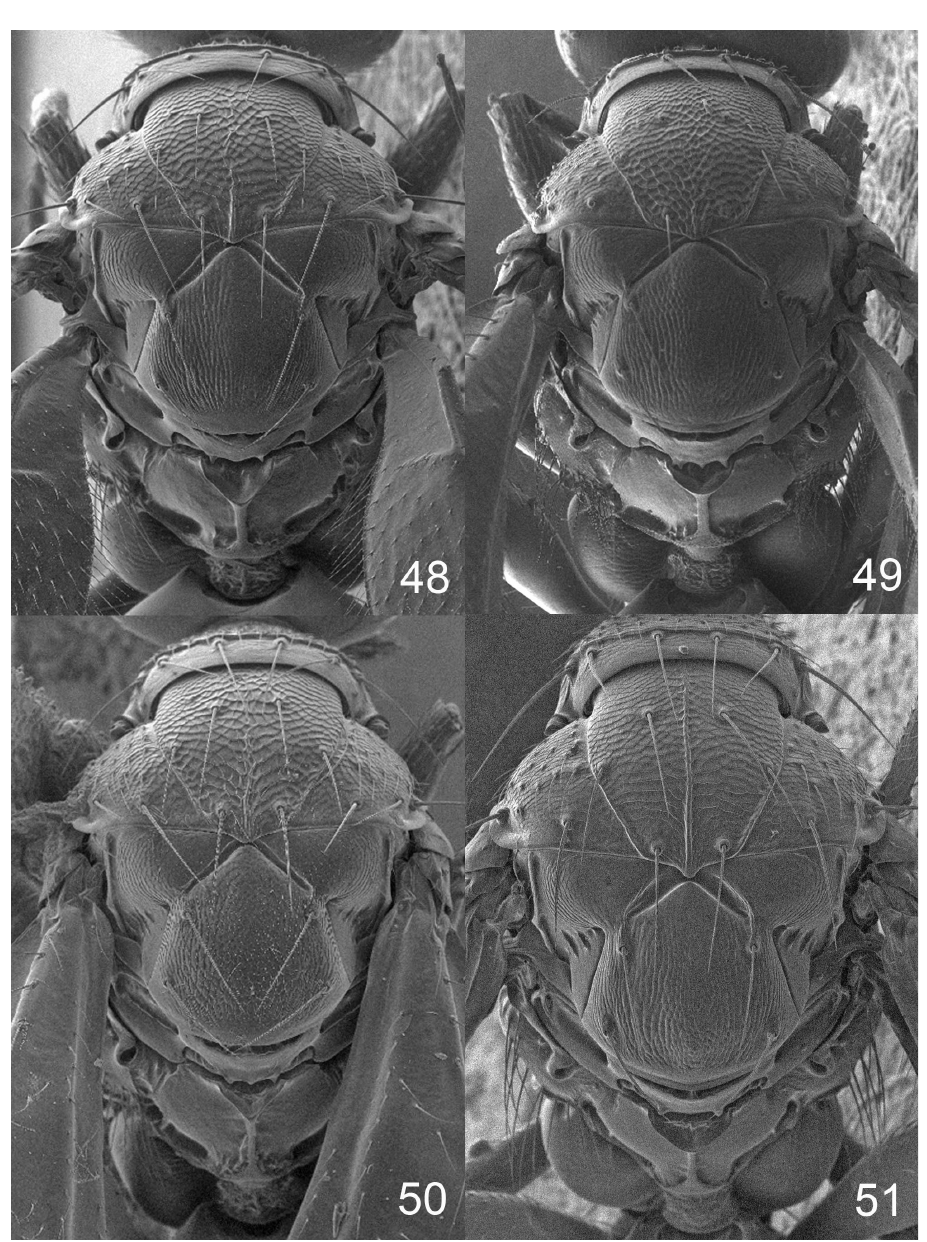
Figures 48–51. Euplectrus spp., mesosoma dorsal, female: 48 E. bicolor (Swederus) 49 E. intactus (Walk- er) 50 E. maculiventris Westwood 51 E. flavipes